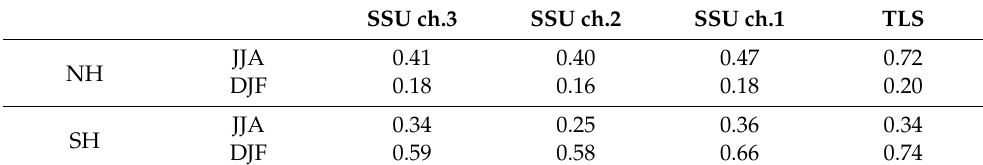
Table 1. Correlation coefficients between stratospheric temperature and total column ozone aver aged in the NH and SH in JJA and DJF over 1979–2020 in SSU channel 1, 2, 3, and TLS.